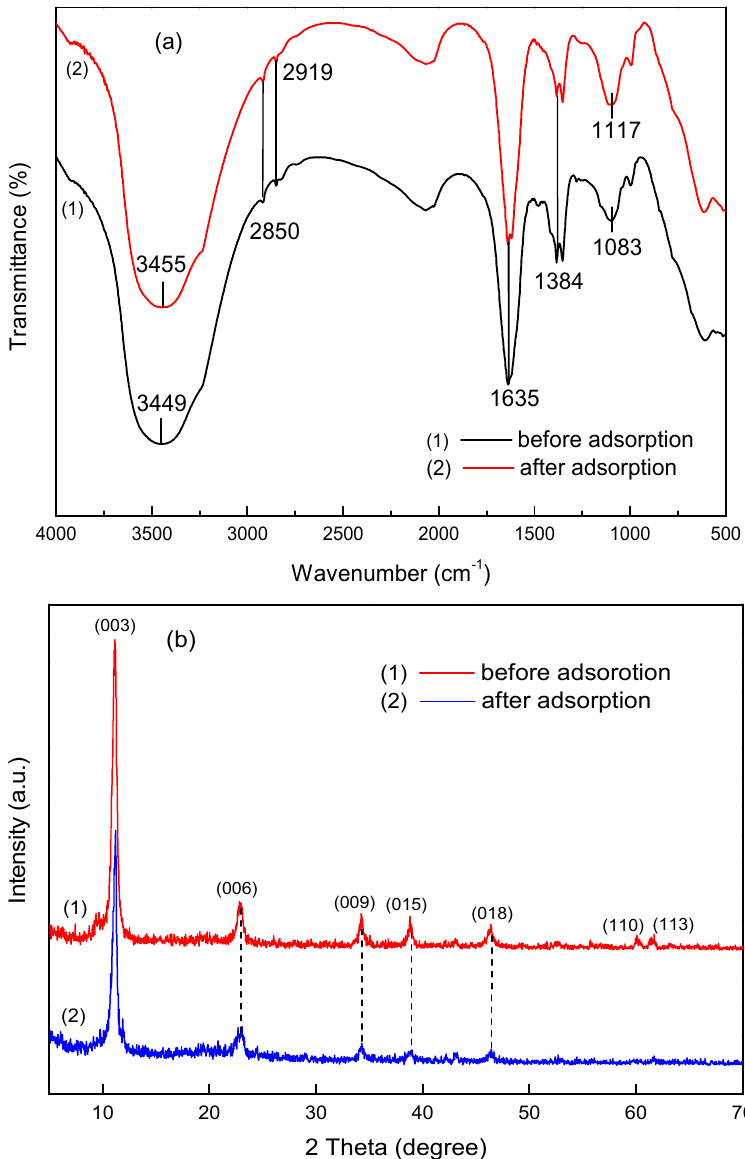
Figure 10. The FTIR spectra ( a ) and XRD patterns ( b ) of hierarchical MgAl-LDH before and after adsorption.